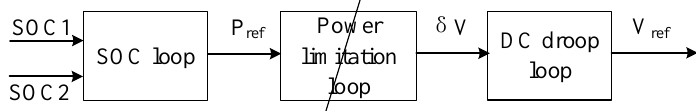
Figure 5. Outer loop control block